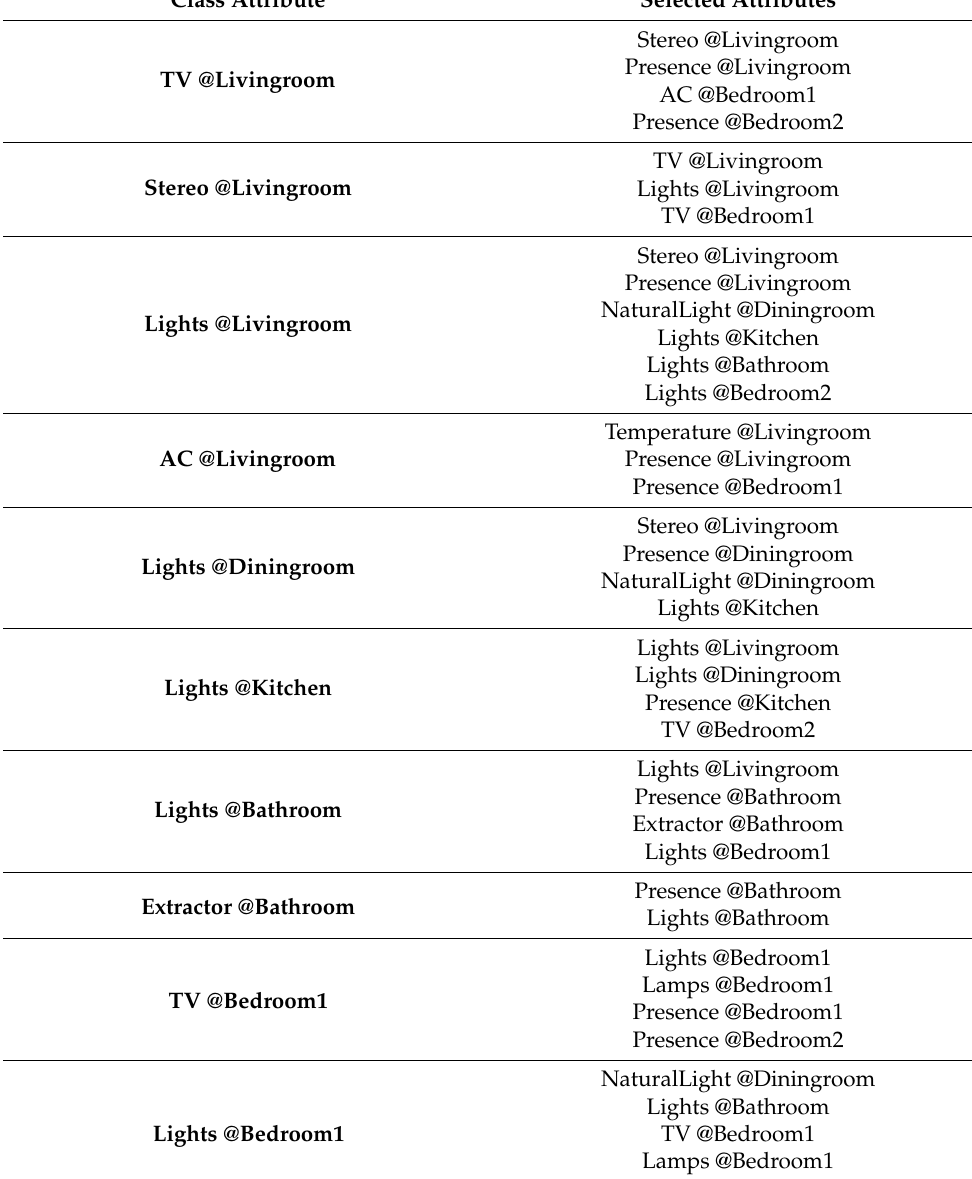
Table 4. Selected attributes for each class